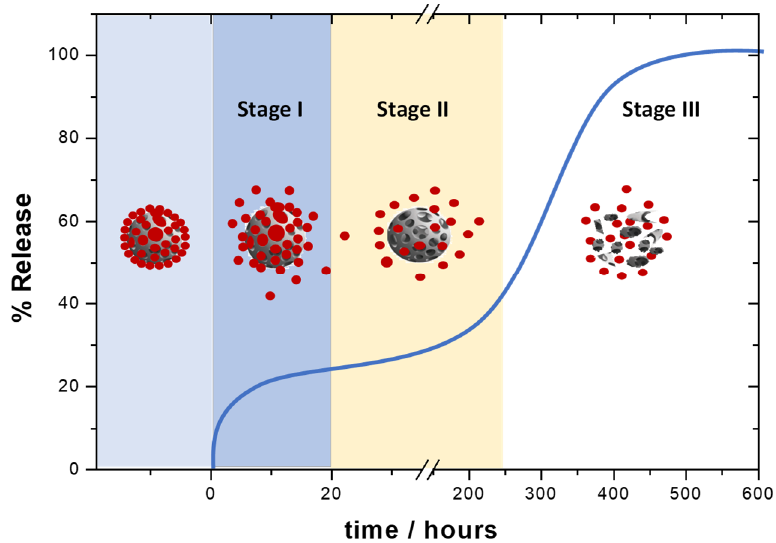
Figure 4. Representative release profile for polymeric NPs. In stage I the drug is quickly released through desorption–diffusion processes. The release of the drug in stage II is governed by diffusion through the polymer matrix or pores. Stage III is governed by the erosion of the polymeric matrix.